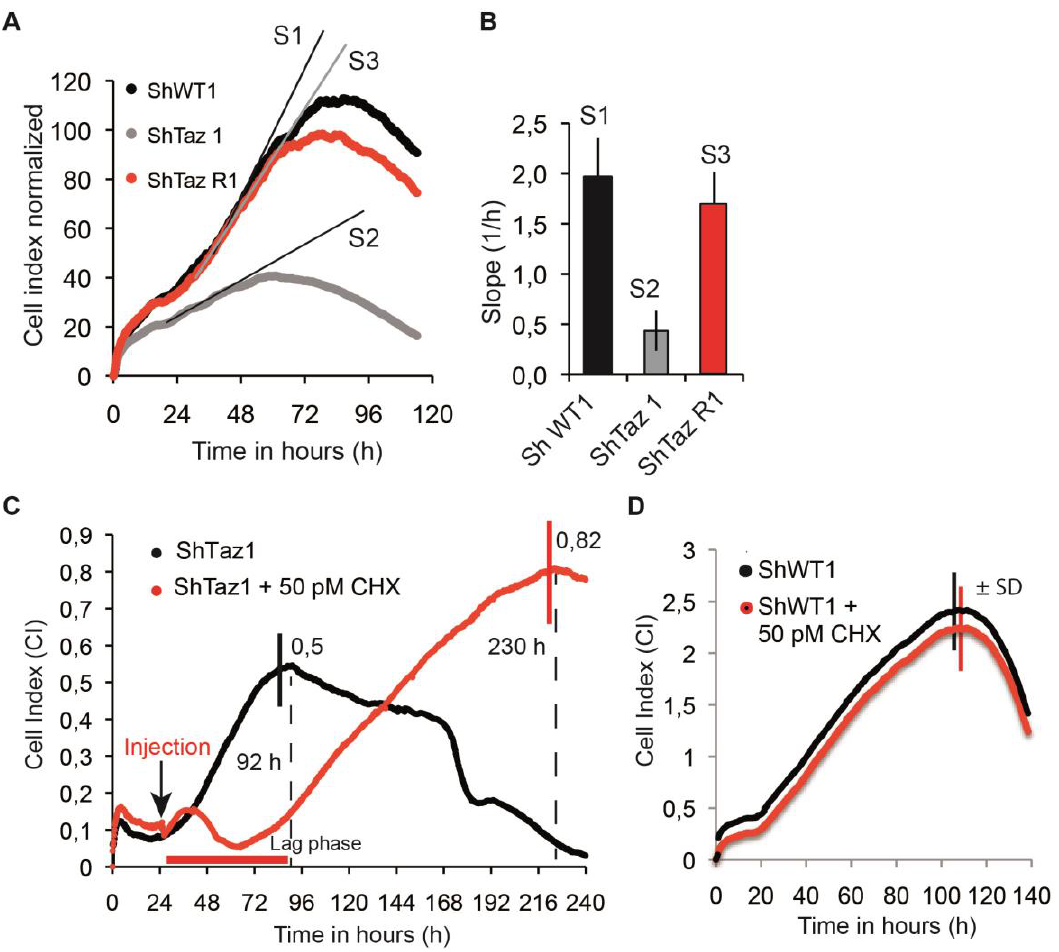
FIGURE 6: CHX improves cell proliferation and viability of human Tafazzin-deficient cells. These experiments used our previously described HeLa cells in which TAZ gene has been knocked down by RNA interference (shTaz1) and two control cell lines, shWT1 and shTaz1R, in which expression of TAZ1 is not inhibited [67]. (A) Growth curves in 200 µL wells inoculated with 5 000 cells. After reaching a plateau, the cells die and detach from their support. S1, S2 and S3 are the slopes of the proliferation state for each cell lines. (B) Relative slopes (1/h) deduced from the proliferation curves shown in panel A. (C) xCELLigence recording of ShTaz1 proliferation in absence or presence of CHX at a concen- tration of 50 pM. CHX was added (black arrow) after a 24-hour adhesion step. The cultures were inoculated with 5 000 cells in 200 μL wells. The optimal Cell Index values are indicated along the curves as well as the time (in hours) taken to reach the inflexion point. The horizontal red bar stands for the 48 hours lag phase induced by CHX. Four independent experiments with 4 wells for each growth condition have been done (16 wells in total for establishing mean values). the ±SD is directly drawn on the top of the curves (in black for ShTaz1 and in red for SgTaz1 + 50 pM CHX). (D) xCELLigence recording of ShWT1 proliferation in absence or presence of CHX at a concentration of 50 pM. The cultures were inoculated with 5 000 cells in 200 μL wells. CHX was added before the binding of the cell to the substrate in this case in order to avoid the perturbations induced by the injection of CHX along the trace; the ±SD is directly drawn on the top of the curves (in black for ShWT1 and in red for SgTaz1, there is no significant